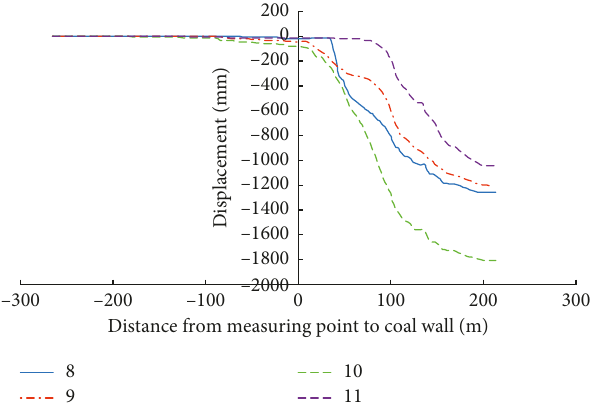
Figure 20: The displacement curves of the overlying strata at the third measuring